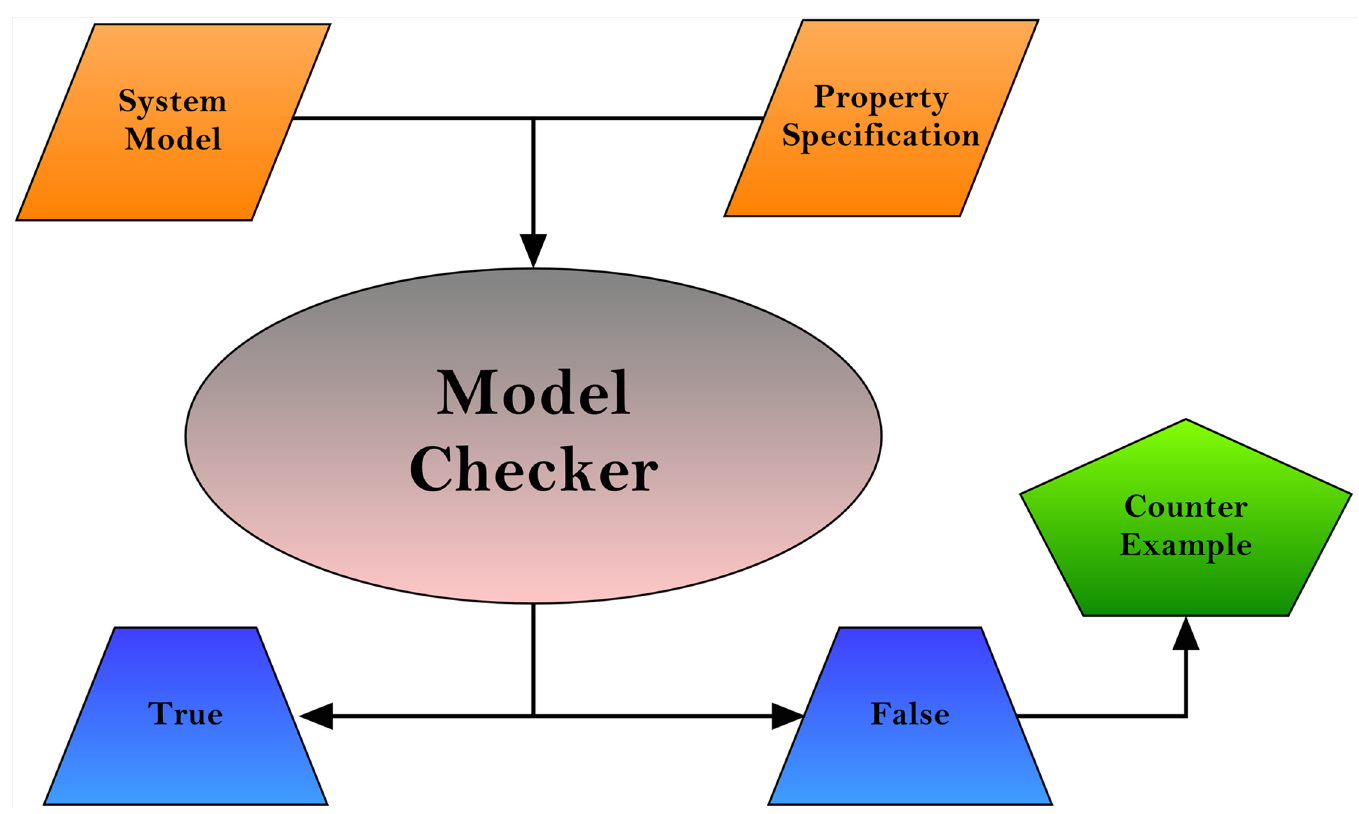
Fig 6. Model Checking Process. Model checker takes the system model and property specification as input and generates two types of output: (1) true which means property is satisfied (2) false with counter example which means property is not satisfied.